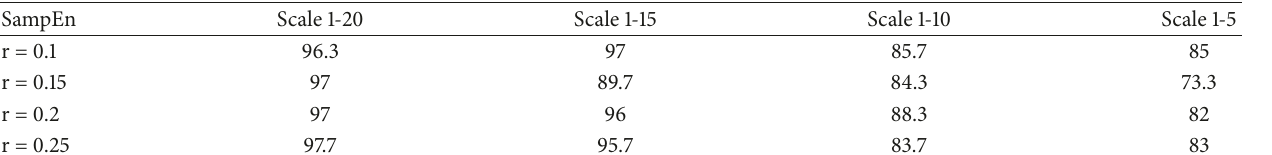
Table 3: Accuracy (%) using cubic SVM and 5-fold CV.